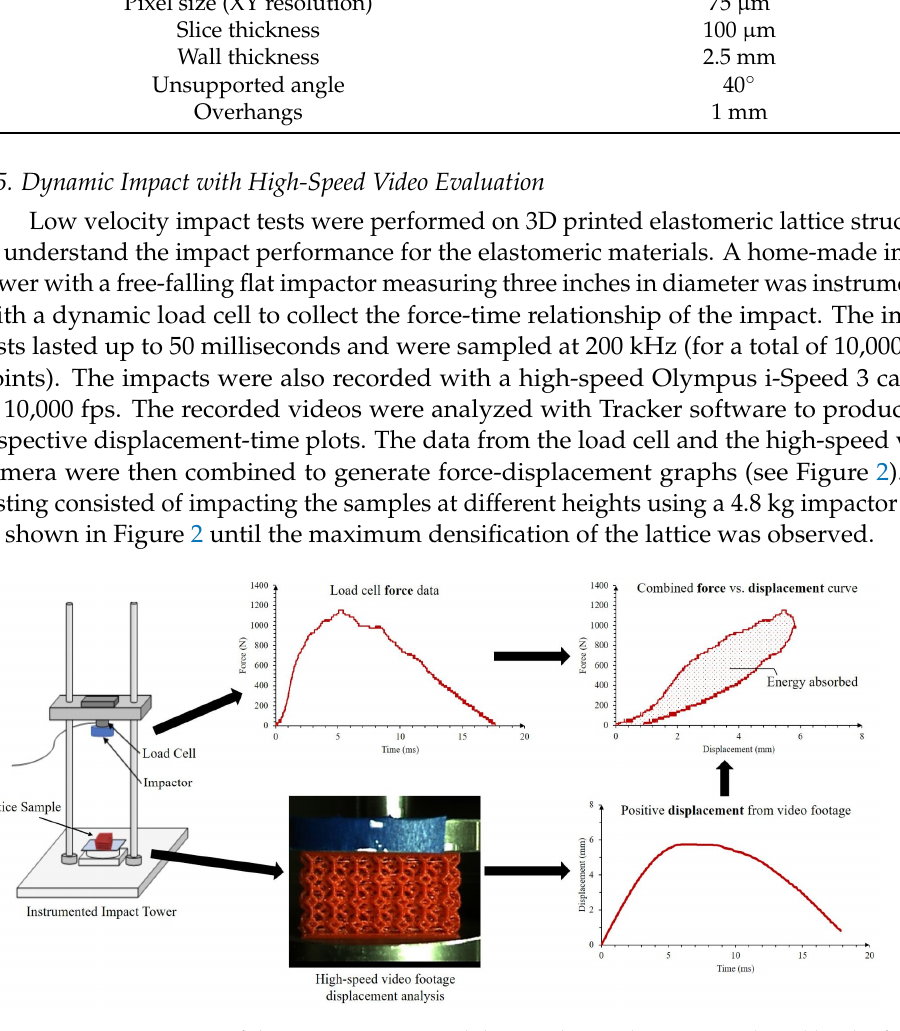
Figure 2. Representation of the impact testing and data analysis. The area enveloped by the force vs. displacement curve is the energy absorbed by the lattice and is shaded above.